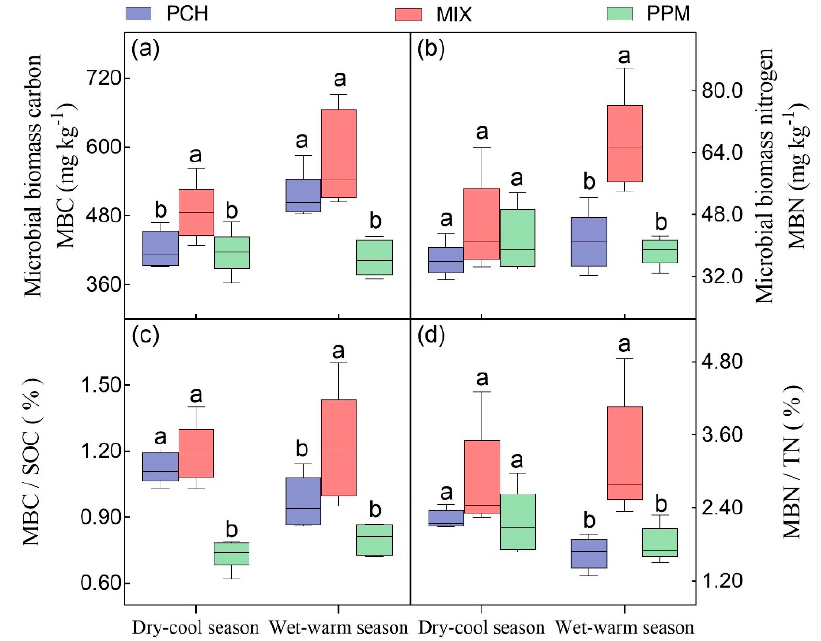
Figure 2. Soil microbial biomass in three plantations in different seasons (( a – d) refer to MBC, MBN, MBC-to-SOC and MBN-to-TN). Different letters above the bars denote significant differences at p < 0.05 level by LSD multiple comparisons among stand types ( n = 5).